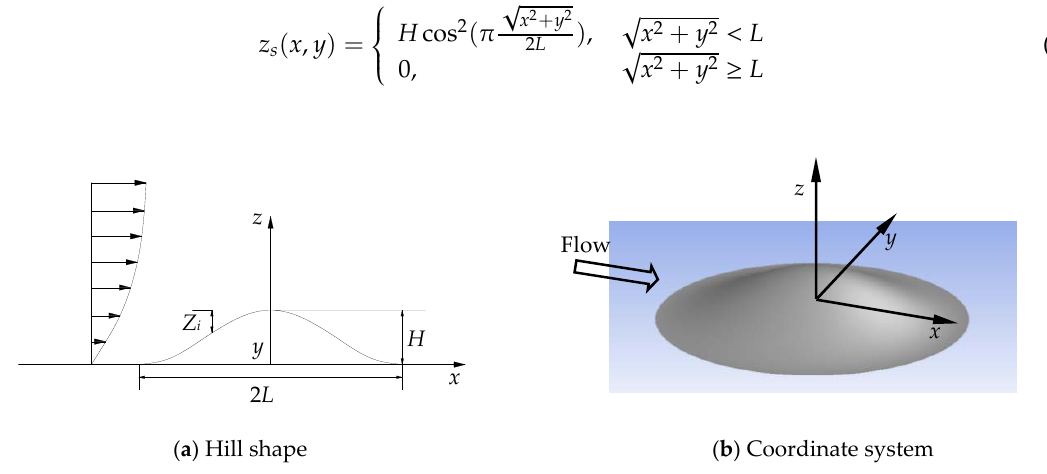
Figure 1. Coordinate system and notations.